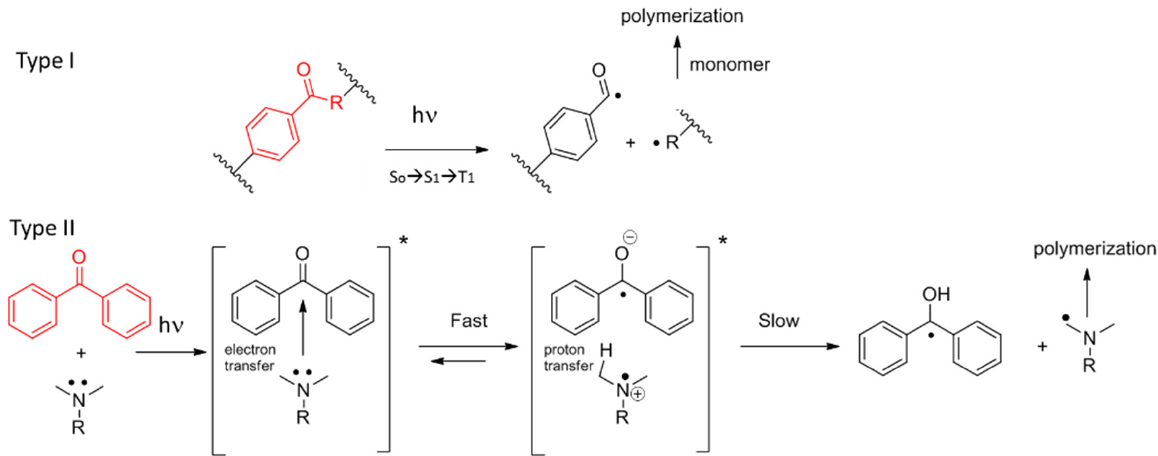
Figure 2. Radical generation of type I and II photoinitiators upon light irradiation.